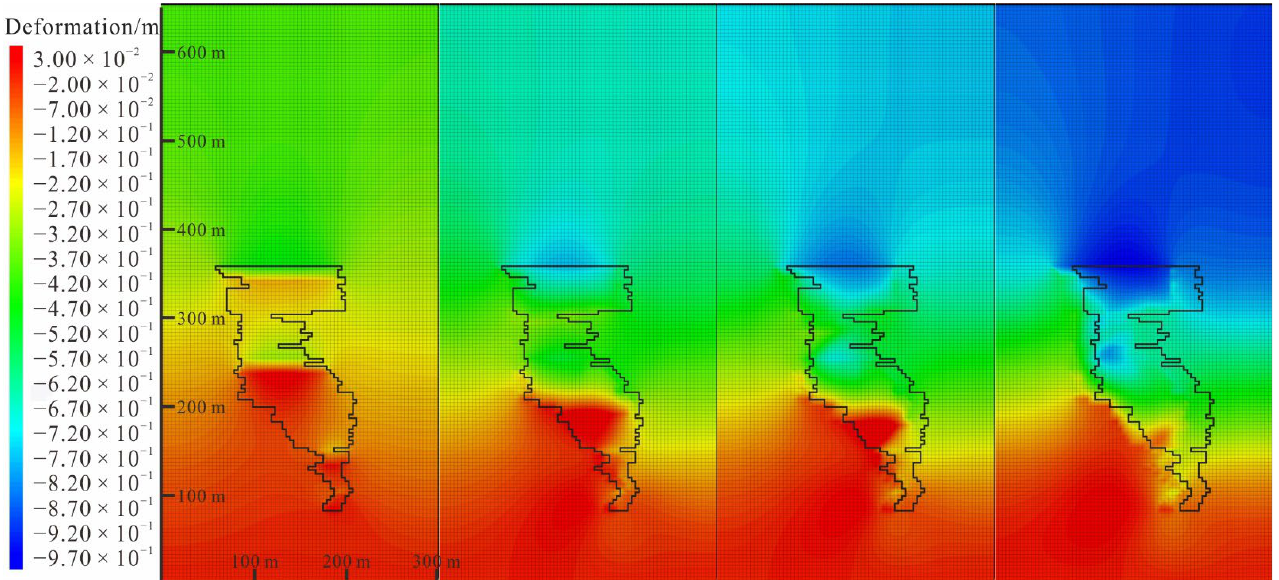
Figure 8. Numerical simulation results of the typical section.